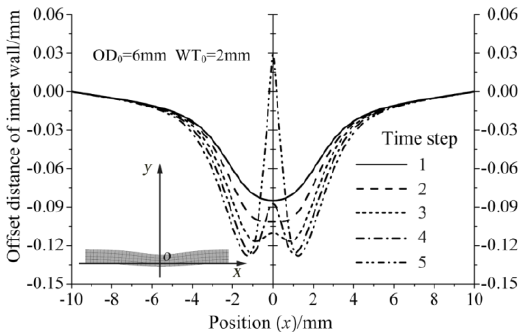
Figure 10. Geometrical change of inner tube wall during necking process.